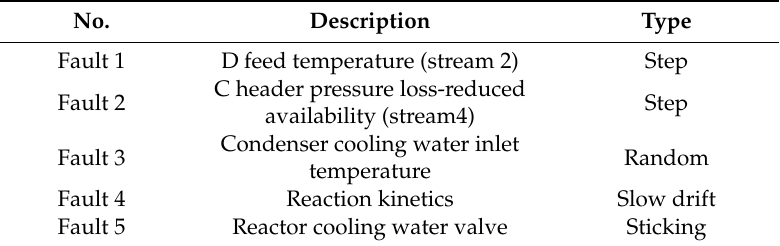
Table 1. Faults description of TECP.